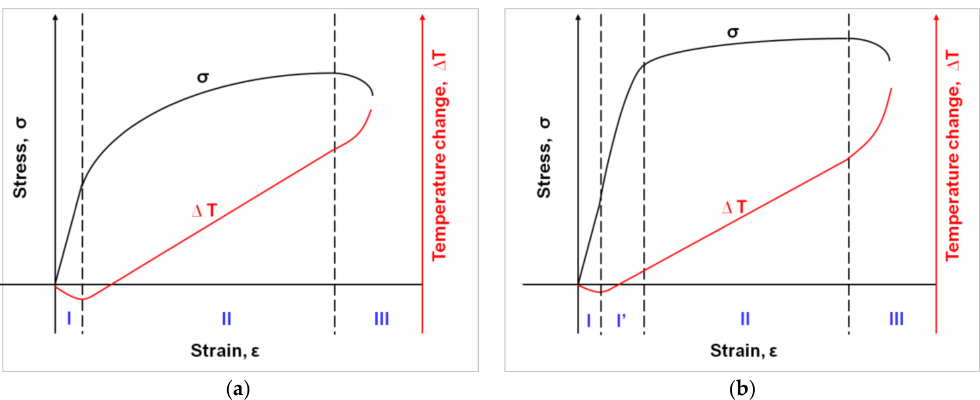
Figure 4. General scheme of stress σ and temperature change ∆ T versus strain ε in tension up to rupture representing behavior of ( a ) any solid material, where subsequent deformation stages are distinguished: I = linear elastic, II = plastic, III = damage; ( b ) Gum Metal, where subsequent deformation stages can be distinguished: I = linear elastic, I’ = nonlinear mechanically reversible, II = plastic, III =